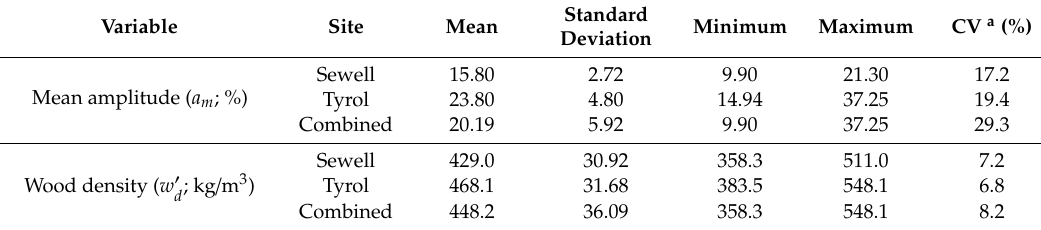
Table 3. Descriptive statistical summary of the mean amplitude and corresponding wood density measurements derived from the 122 cross-sections found in the stump and breast-height disks from the two sites (two disks / tree × 31 sample trees at Sewell (62) and two disks / tree × 30 sample trees at Tyrol (60) yielded 122 observational